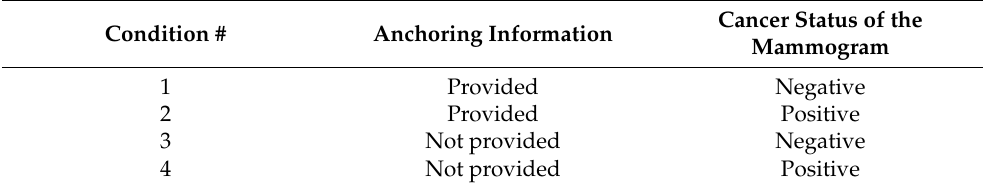
Table 2. Experimental conditions in Study